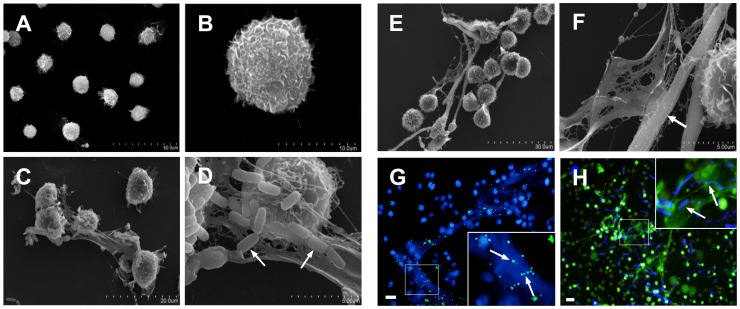
Scanning electron microscopy (SEM) and fluorescence micrographs of microbes trapped by METs-LS.J774A.1 macrophages were seeded onto glass cover slips and incubated with E. coli or C. albicans for 180 min. A–B: SEM images of uninfected J774A.1 cells. C–D: SEM images of METs-LS induced by E. coli. The white arrows indicate the bacteria adhered to the surface of METs-LS. E–F: SEM images of METs-LS induced by C. albicans. The white arrows indicate the fungus trapped in the METs-LS. G: Fluorescence photograph of DNA (Blue) and FITC-labeled E. coli (Green). H: Fluorescence photograph of DNA (Green) and calcofluor white-stained C. albicans (Blue). Both microbes co-localized with METs-LS. In (G) and (H), samples were washed twice with PBS to remove unbounded microbes before analysis. These experiments were repeated independently 3 times with similar results. Scale Bars: 20 µm.